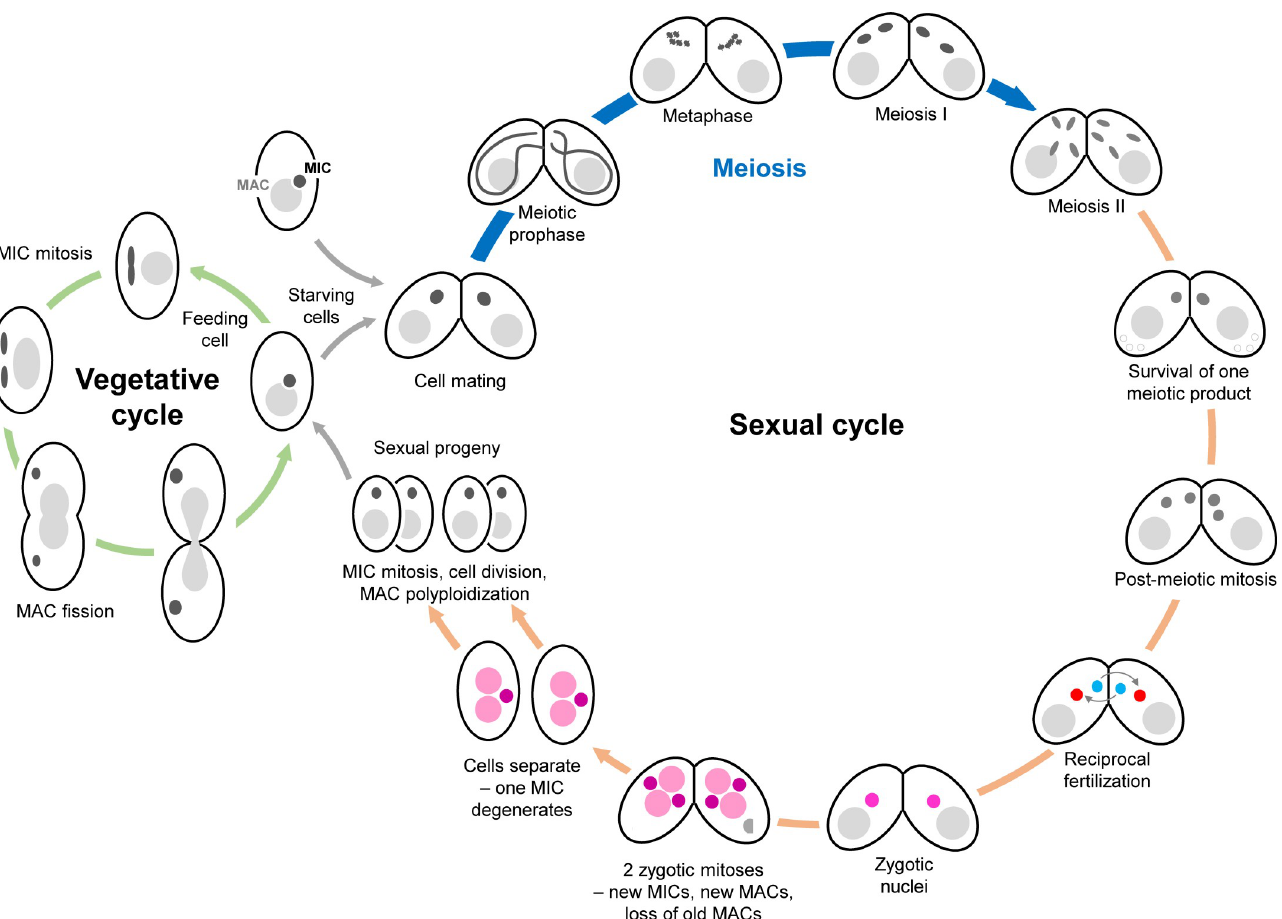
Fig 1. Vegetative and sexual cycles of Tetrahymena thermophila . During vegetative growth (left), the 2 nuclei divide asynchronously. First, the germline nucleus (the MIC) divides mitotically, then the somatic nucleus (MAC) stretches and splits amitotically, and, finally, the cleavage furrow closes to divide the cell. Meiosis is induced when starved cells of 2 different mating types meet (right). The cells mate (“conjugate”), and their MICs undergo synchronous meioses. Three of the 4 meiotic products are degraded, while the remainder is selected and recruited to the conjugation junction, where it undergoes a postmeiotic mitosis. This division produces 2 gametic nuclei, one migratory and the other stationary. Migratory nuclei are exchanged between the partner cells and fertilize their stationary nuclei. The resulting genetically identical zygote nuclei divide twice, and the daughter nuclei differentiate into the new MICs and MACs of 4 sexual progeny cells, while the old MAC is eliminated via autophagy. As soon as new MACs form, they start to polyploidize. The 5 MIC chromosomes are fragmented into about 200 MAC chromosomes, and about one-third of the MIC genome is eliminated by the removal of thousands of internal eliminated sequences (see [76]). MAC, macronucleus; MIC,